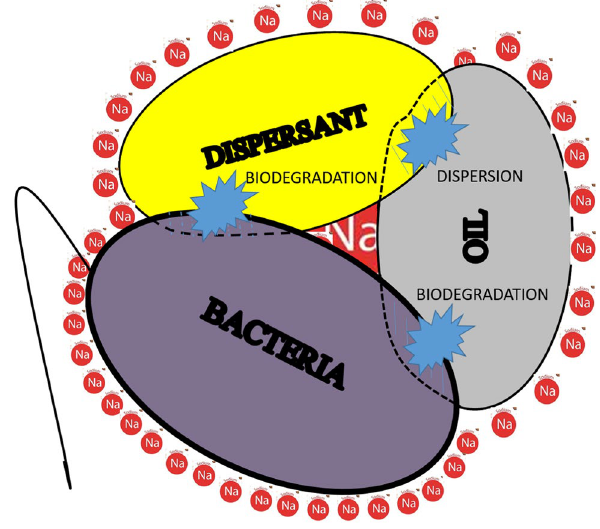
Fig. 3 Role of bacteria in oil/dispersant biodegradation under saline water